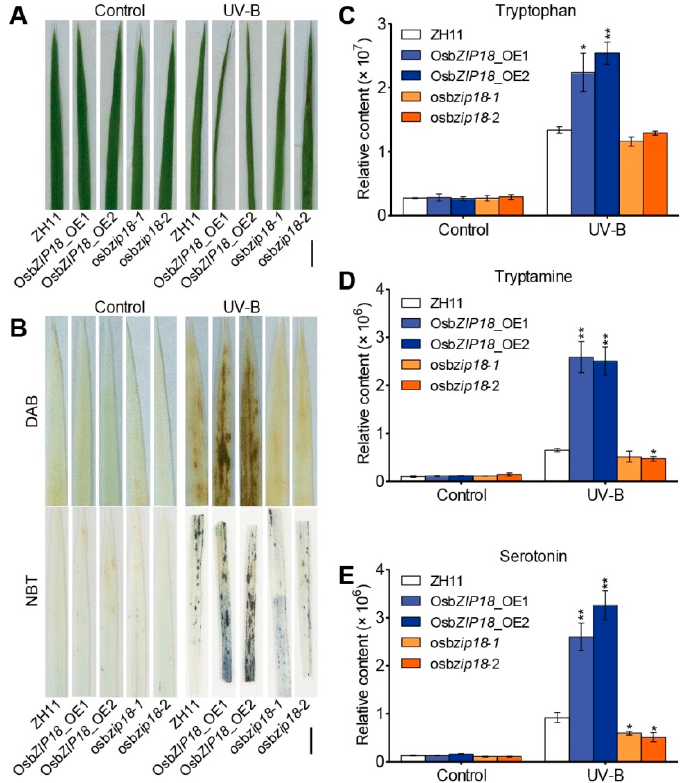
Figure 5. The phenotype and serotonin biosynthesis of the OsbZIP18 transgenic lines and their wild type (ZH11) under control and UV-B radiation. ( A ) Phenotype comparison of the leaf curl under the control or UV-B stress conditions. ( B ) DAB and NBT staining were used to assess the accumulation of H 2 O 2 and O 2- , respectively. Fourteen-day-old seedlings grown in a light incubator were treated with or without UV-B for 36 h before staining. ( C – E ) The accumulation of tryptophan ( C ), tryptamine ( D ), and serotonin ( E ) in the leaves under UV-B radiation. All data were compared with ZH11. Scale bars = 5 mm for ( A , B ). The p -value was calculated using Tukey’s test, n = 3. * p < 0.05 and ** p < 0.01.